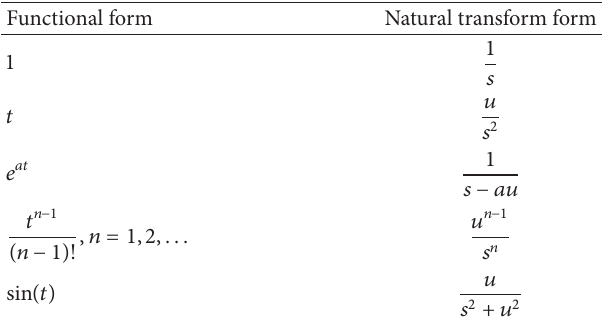
Table 1: List of some special natural transforms. Functional form Natural transform